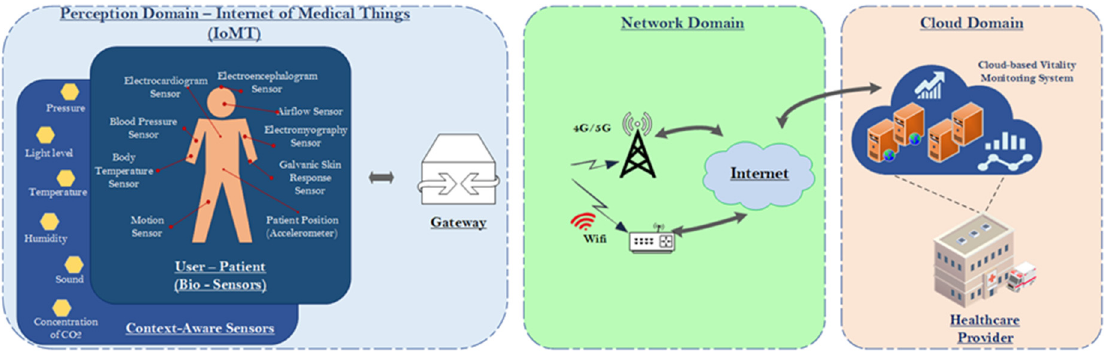
Figure 1. IoMT edge network architecture and key components.